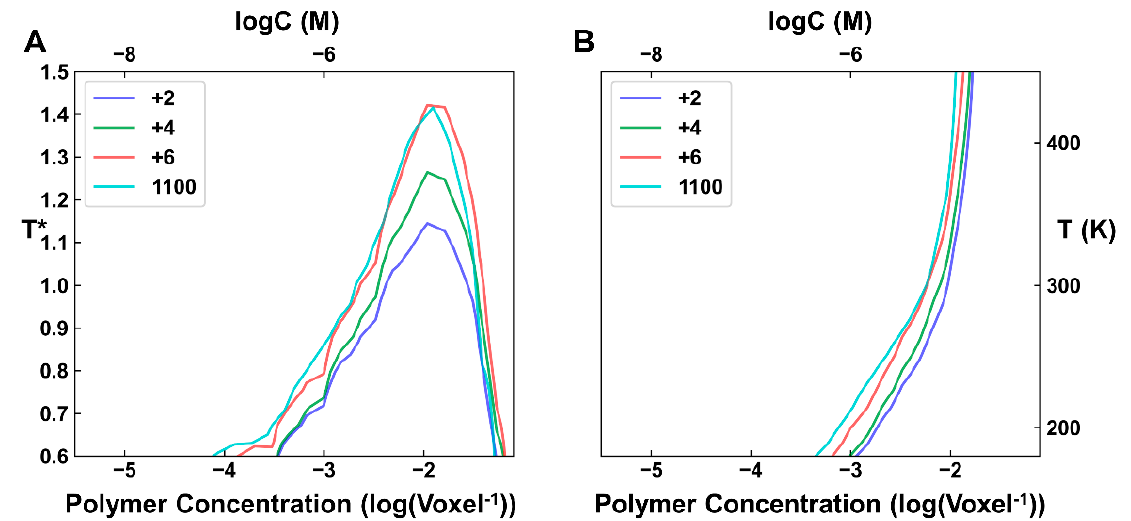
Figure 6. Influence of the linker patch charge neutral on the phase behaviors ( L = 40). ( A , B ) Contour of ρ = 0.025 ( A ) and φ C = 0.5 ( B ) for systems with a positively and a negatively charged patch. The label ‘+2’, ‘+4’, ‘+6’ refers to the absolute net charge for each charged patch. The label ‘1100’ refers to the linker architecture, in which two consecutive positively charged patches (that is ‘1’) connected to two consecutive negatively charged patches (that is ‘0’).